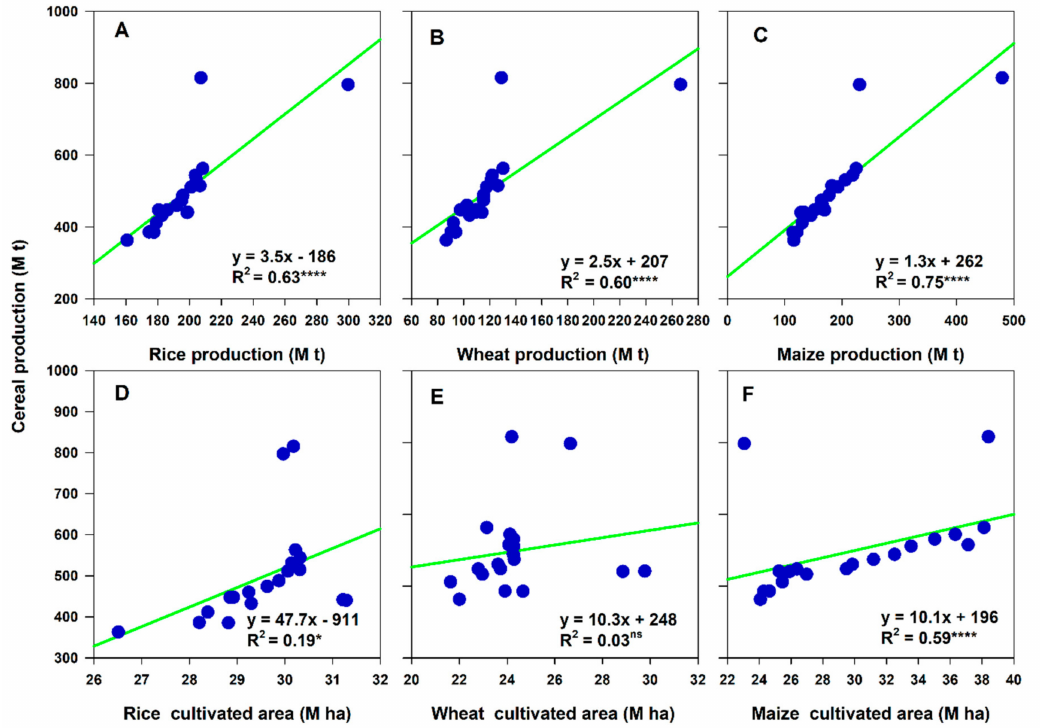
Figure 8. Correlations between Chinese total cereal production and rice production ( A ), wheat production ( B ), maize production ( C ), rice cultivated area ( D ), wheat cultivated area ( E ), and maize cultivated area ( F ) from 1998 to 2016. * and **** indicate significance at p < 0.05 and p < 0.0001, respectively. Ns means nonsignificant at p <